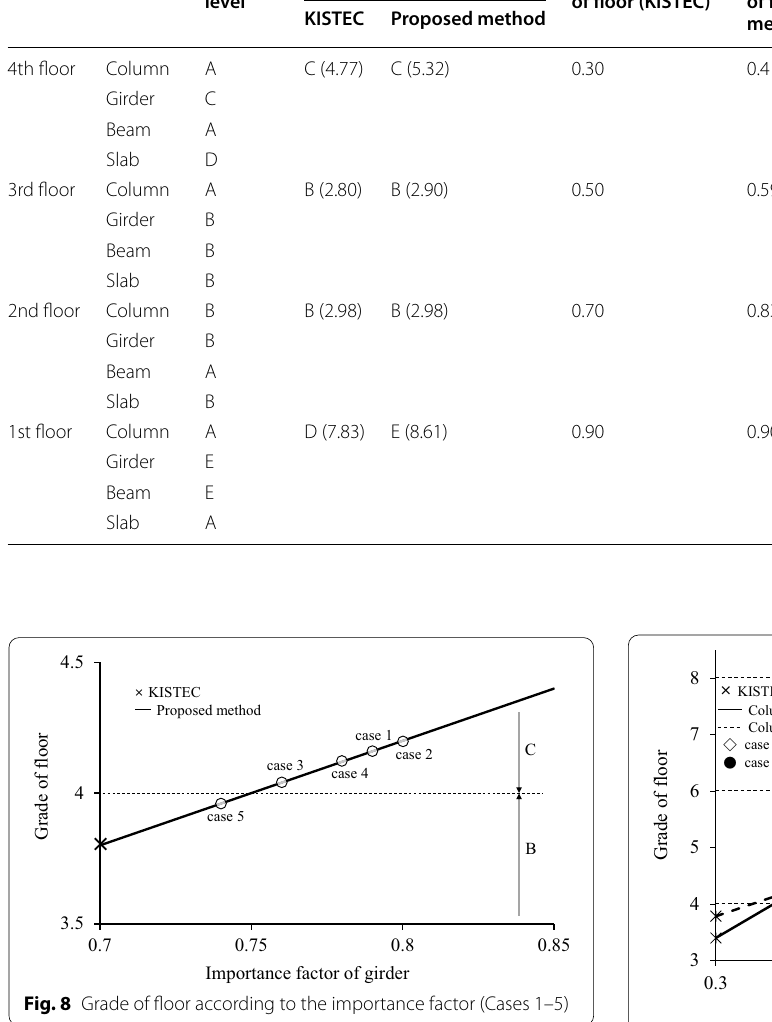
Fig. 9 Grade of floor according to the importance factor (Cases 6–9)